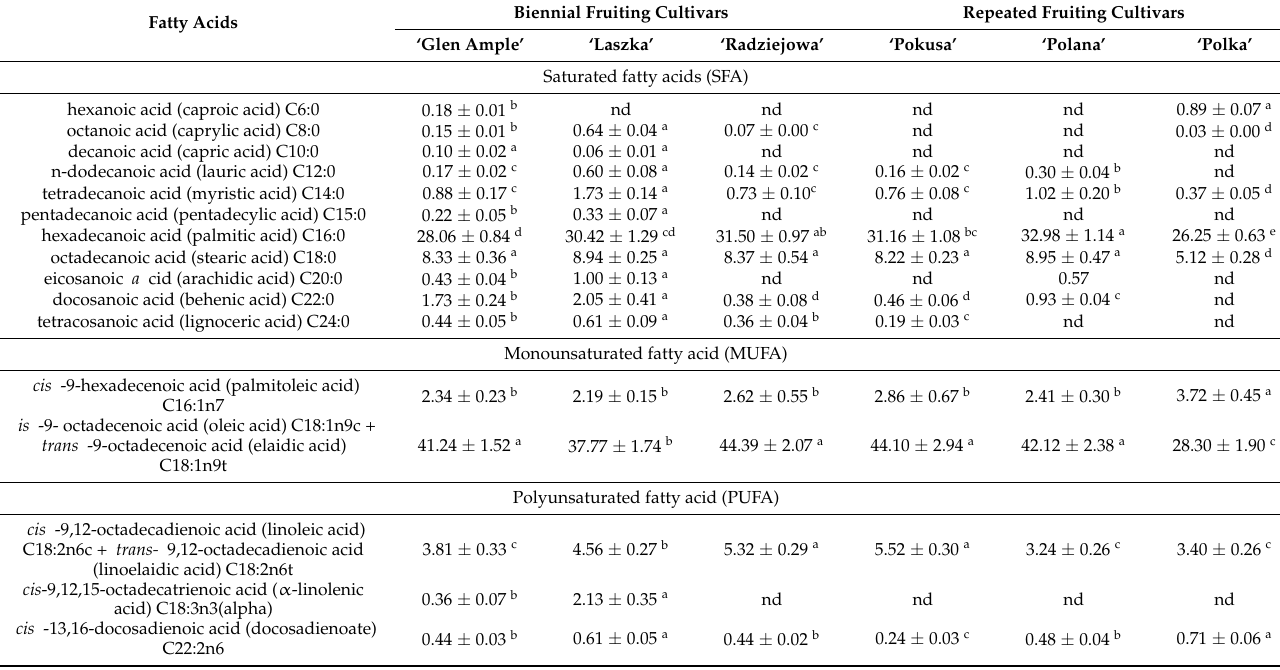
Table 4. Profile of saturated fatty acids (SFAs), monounsaturated fatty acids (MUFAs), and polyunsaturated fatty acids (PUFAs) in the pollen of R. idaeus cultivars (%). Fatty Acids Biennial Fruiting Cultivars Repeated Fruiting Cultivars ‘Glen Ample’ ‘Laszka’ ‘Radziejowa’ ‘Pokusa’ ‘Polana’ ‘Polka’ Saturated fatty acids (SFA)